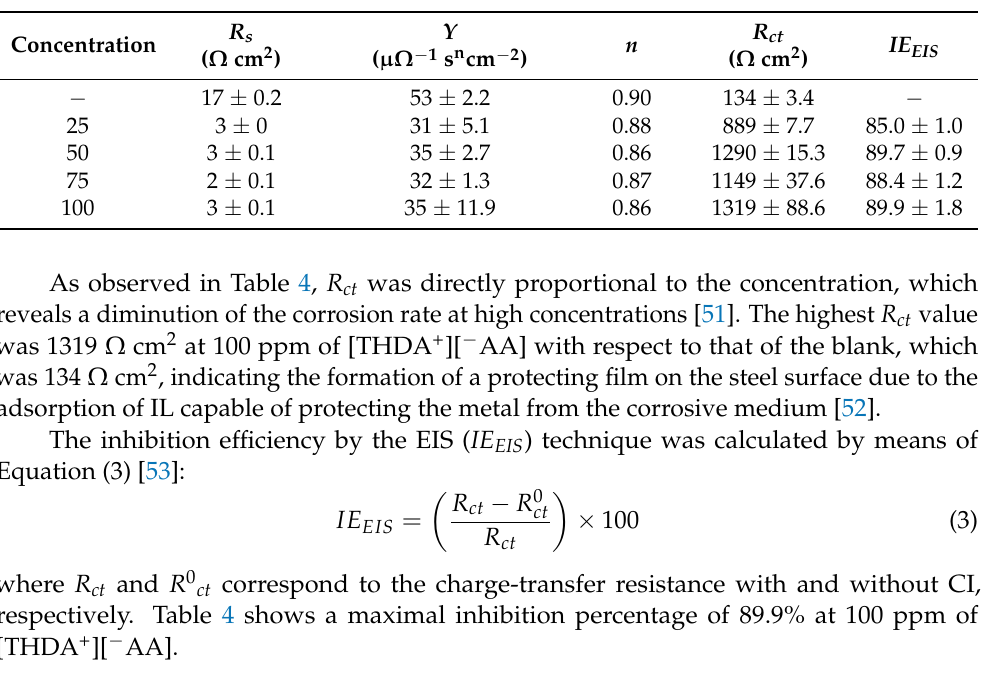
Table 4. EIS parameters for the corrosion of API X52 steel in 0.5 M HCl in the absence and presence of [THDA + ][ −